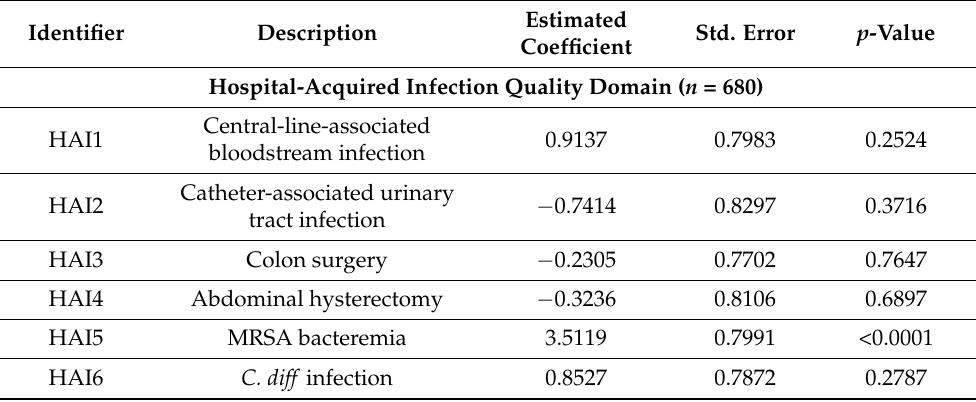
Table 2. Results across domain-specific ordered probit models of association between MSPB and quality outcome